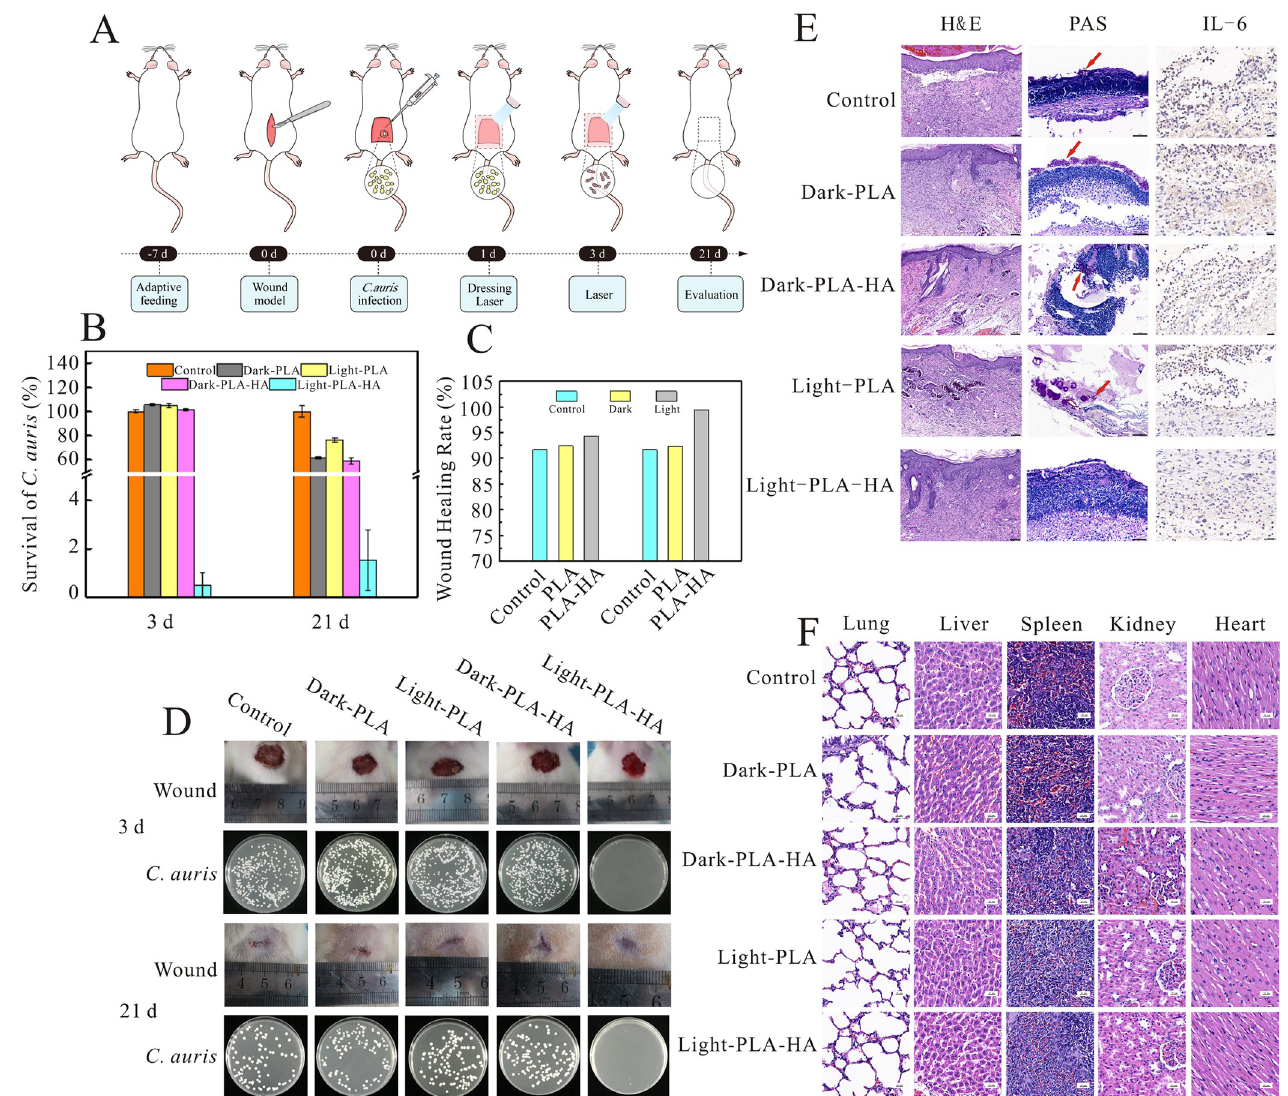
Fig 5. Antifungal efficacy and compatibility of PLA-HA in treating cutaneous C . auris infections. (A)Schematic diagram of cutaneous wound infection with C . auris and treatment with PLA-HA. Rats were evaluated on the 3rd and 21st days. (B) Survival rate of C . auris in the infected wound sites treated with PLA-HA and PLA. (C) Corresponding wound healing rate of rats in different groups. (D) Representative photographs of wounds and fungal burden of PLA-HA and PLA treated rats on days 3 and day 21. (E) Infected skin wound tissue evaluated by H&E staining (day 21, scale = 100 μ m), PAS staining (day 3, scale = 50 μ m) and IHC of IL-6 (day 3, scale = 20 μ m) after PLA-HA treatment. (F) H&E staining of lung, liver, spleen, kidney and heart in different groups after treatment (scale = 20 μ m). Data are presented as the mean ± s.d.